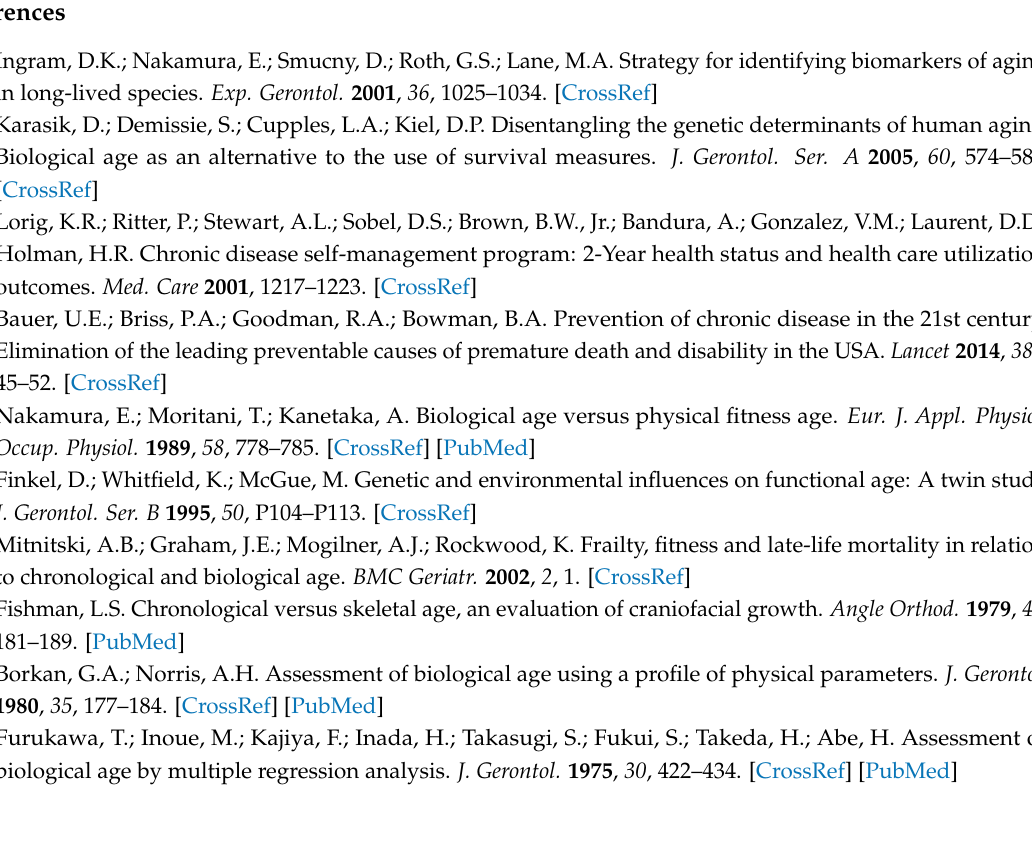
s1, Table S1. Average BA and BA–CA by independent variable. Table S2. Results of linear regression analyses of the association between the use of nutrition data and BA or